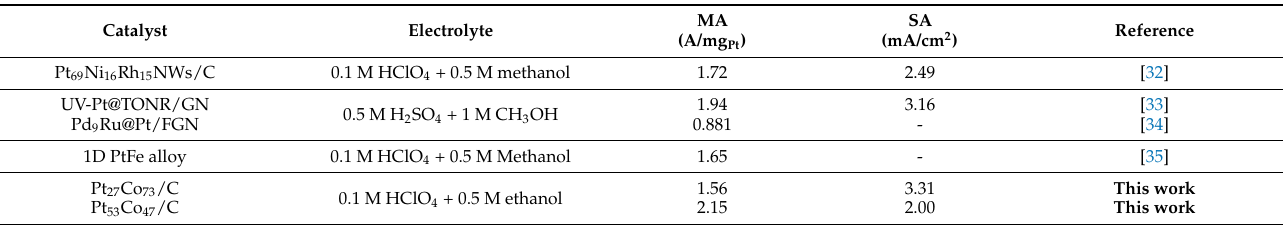
Table 1. Comparison of MOR activities of various